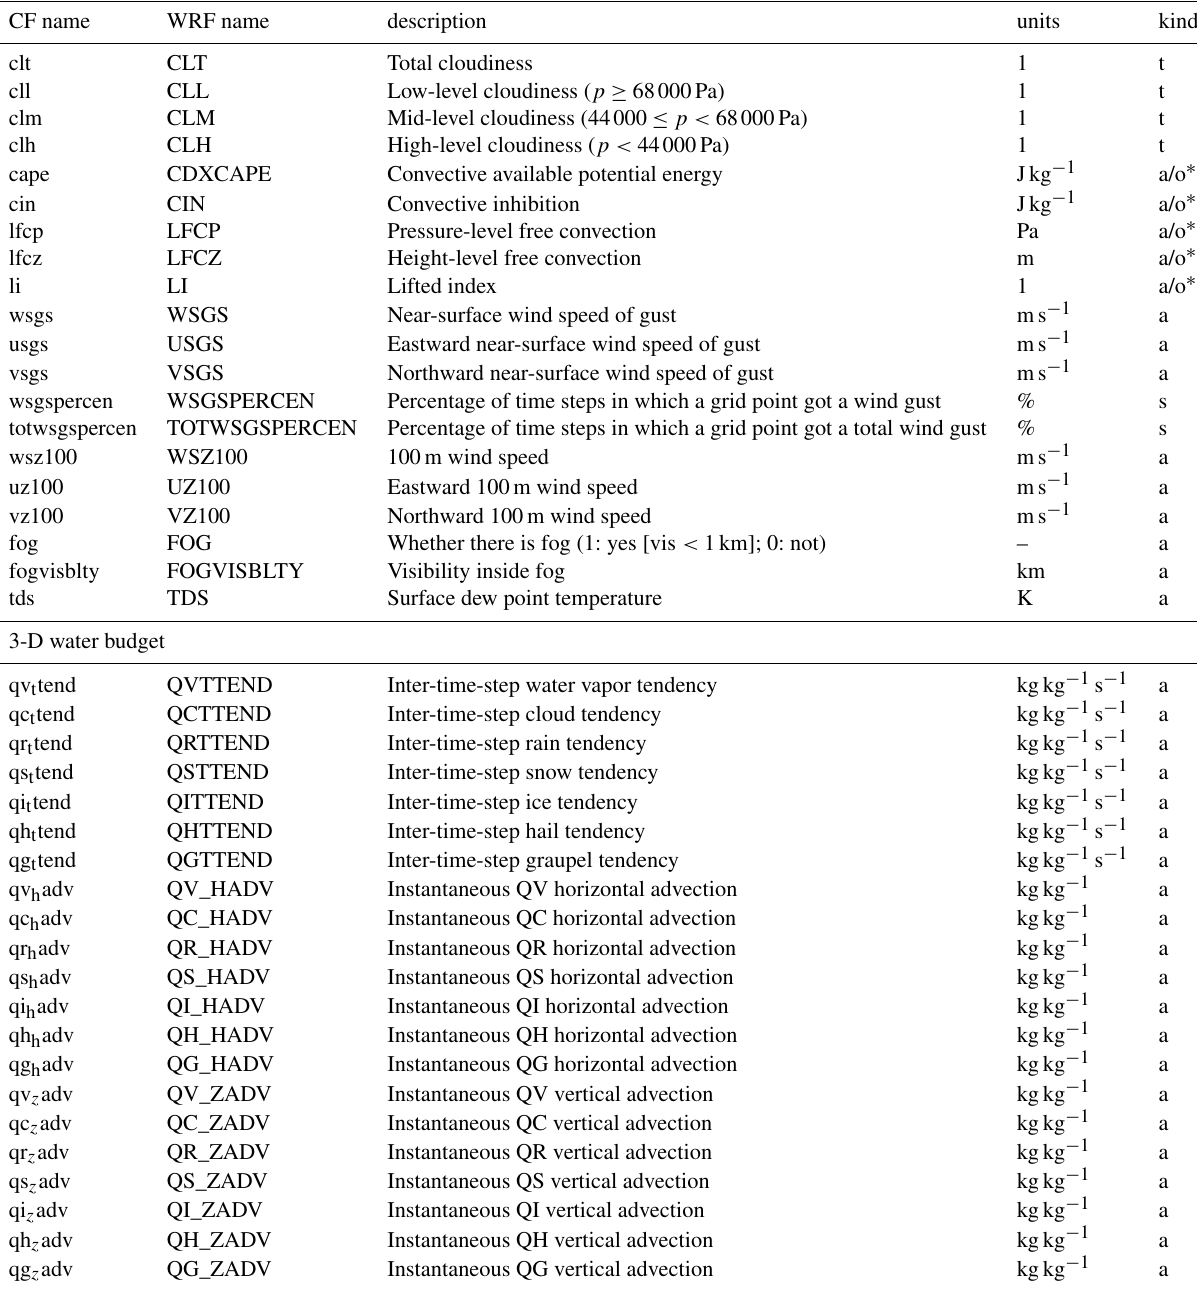
Table B4. As in Table B1, but for the description of CORDEX “instantaneous” variables provided with the module. CF name